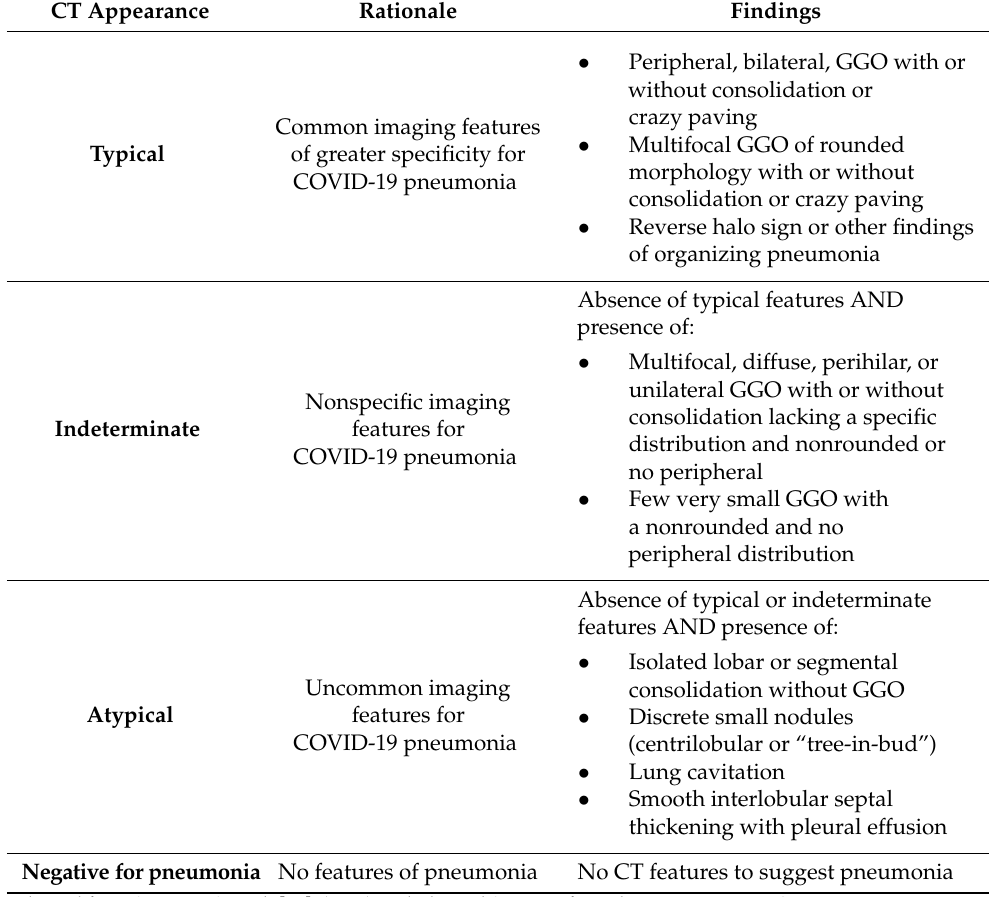
Table 1. Proposed CT classification for patients with suspected involvement by